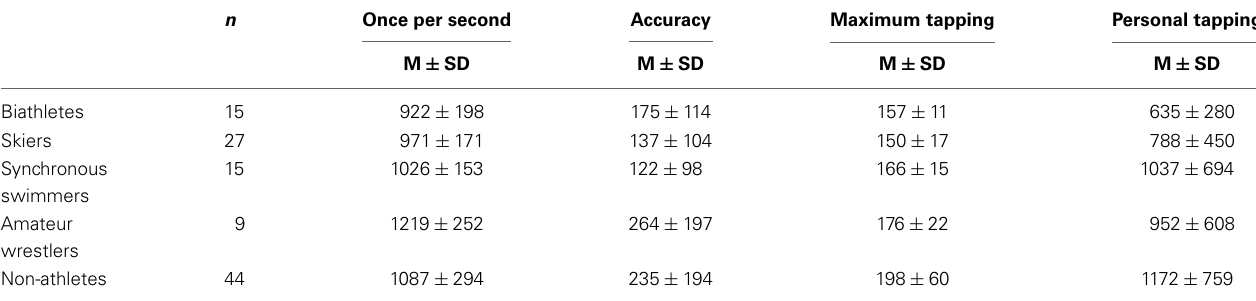
Table 2 | Tapping interval (ms) in the baseline condition for different groups of athletes and non-athlete controls.